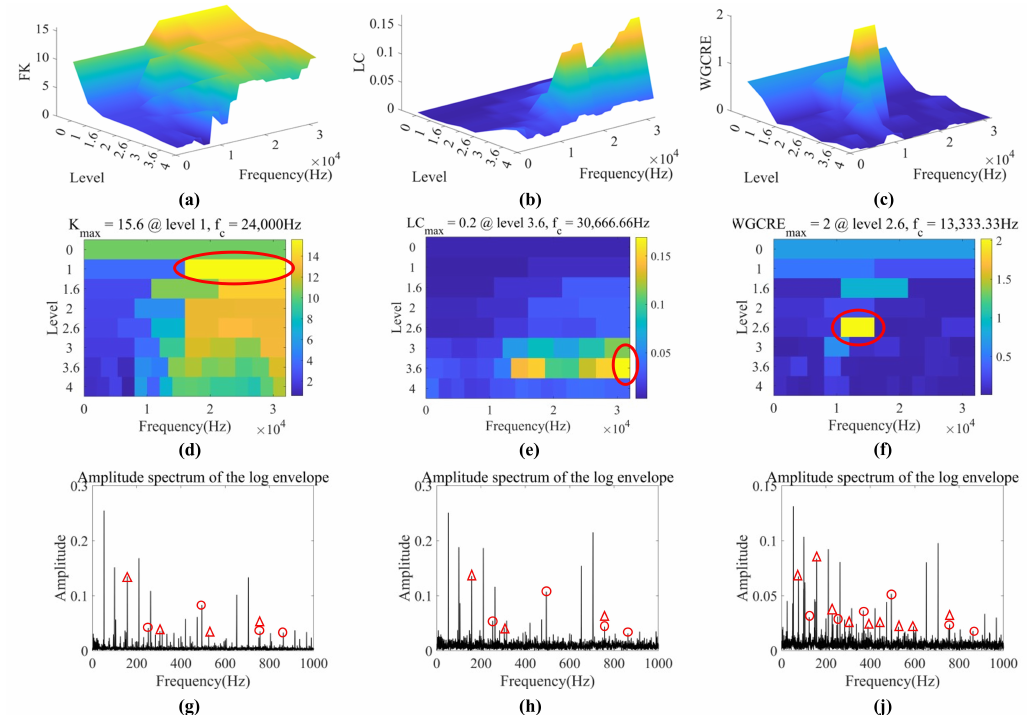
Figure 16. Optimal bands extraction of Case 5 (compound fault). ( a – f ) are 3D and 2D FK, LC , and WGCRE –gram, respectively (optimal bands are circled in red). ( g – j ) are LES of FK, LC , and WGCRE , respectively (BPFOs with harmonics are marked with red triangles and BPFIs are with red circles). In the face of compound fault, the situation is more complicated, and noise is inevitable to a certain extent. The optimal bands of FK and LC can no longer recognize nearly half of the fault harmonics. However, WGCRE still chooses the bar containing the most prominent harmonics as much as possible and can still make certain judgments. As for Case 6, the optimal band extraction and the corresponding LES are shown in Figure 17. FK, LC , and WGCRE select the bands at Level 4 with a center frequency of 21,750 Hz, Level 4 with 2250 Hz, and Level 2 with 15,000 Hz, respectively. The noise amplitude in FK is enormous, which influences judgment. LC only captures two BPFOs and two BPFIs; too challenging to determine these two faults’ positions. WG CRE can capture eight BPFOs and eight BPFIs, thus better than FK and LC .